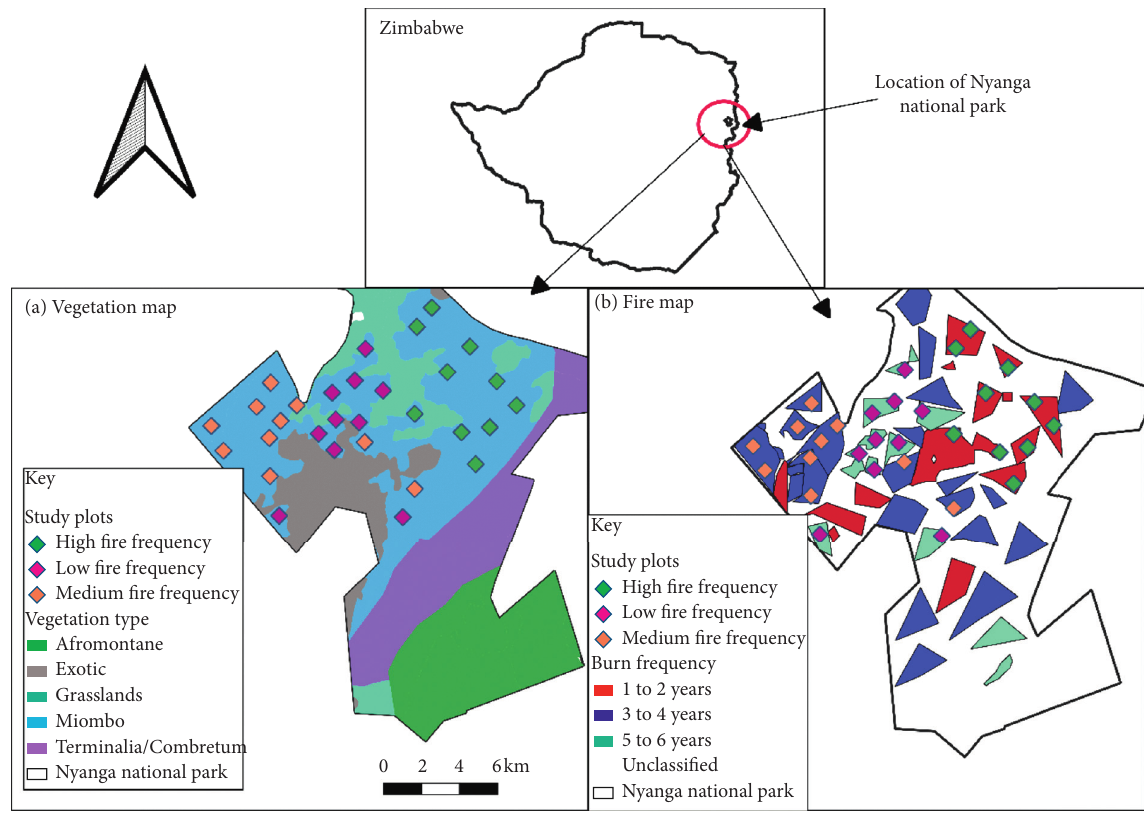
Figure 1: Fire and vegetation map for Nyanga National Park, eastern